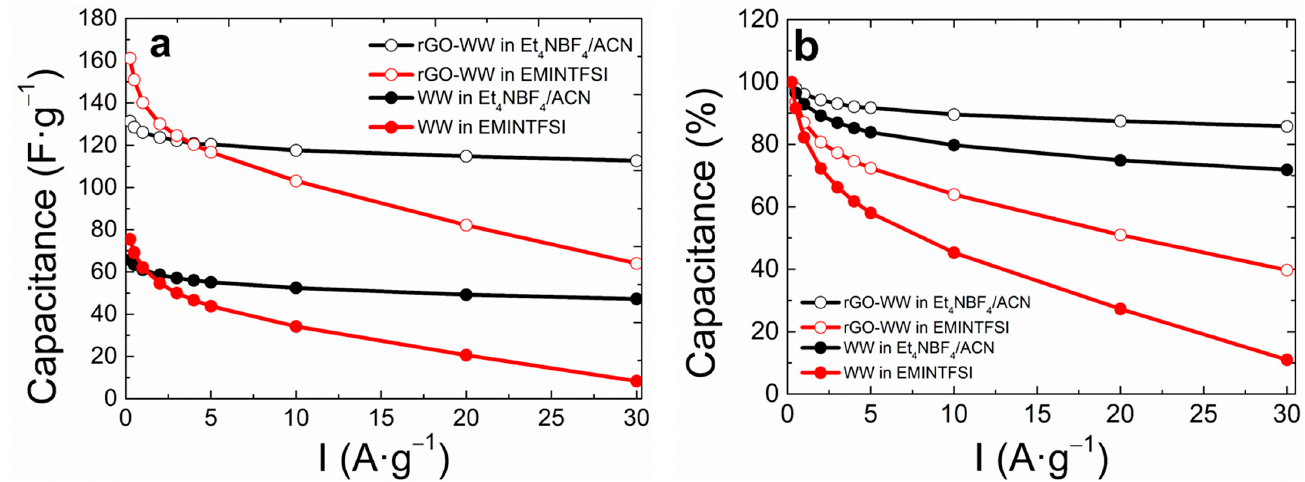
Figure 5. Capacitance evolution vs. current density ( a ) and capacitance retention ( b ) of noted samples.